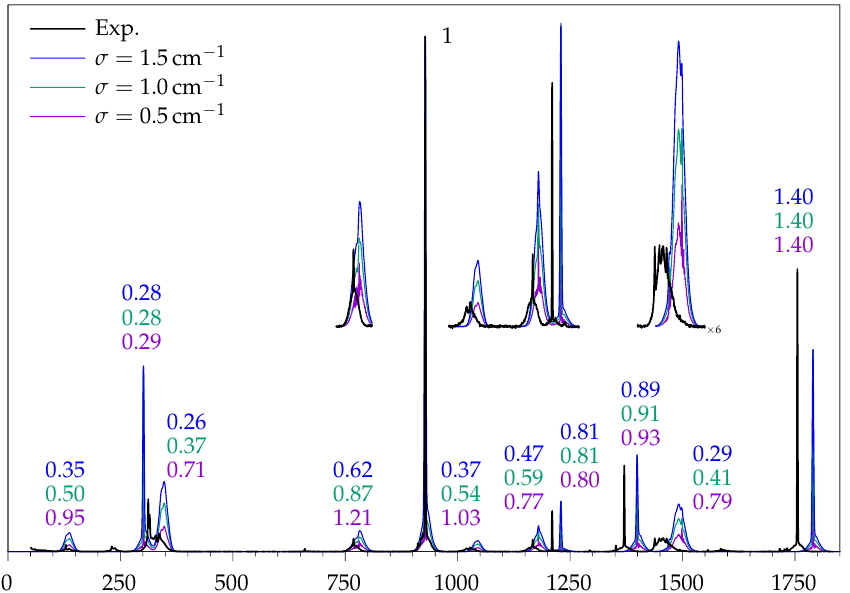
Figure 7. Black trace: Experimental jet spectrum of methyl methanoate. Coloured traces: rovibrational simulations for different Gaussian widths, matched to the strongest peak at 928cm − 1 . In order for the calculated peak height of a vibration to match the experiment, the intensity of the simulated spectrum has to be multiplied with the numbers given.